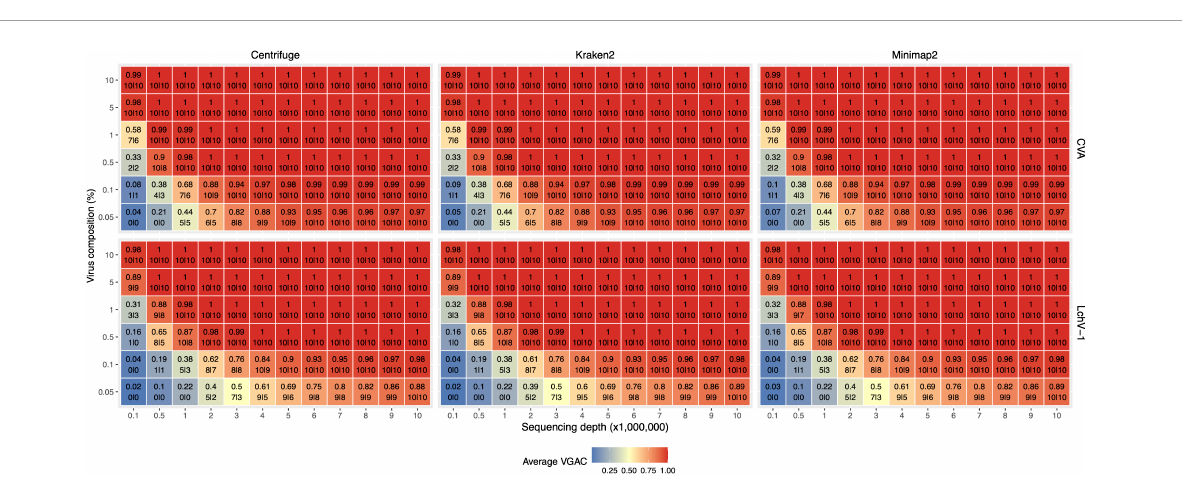
FIGURE5 VGAC dependence on viral abundance, depth of sequencing and identification of replicases. In order to analyze the relationship of VGAC (viral genome assembly coverage) on viral abundance, depth of sequencing and the presence of replicases, synthetic HTS data were generated with different abundance of viral reads. The viruses with the shortest and the longest genome length of the Pavium panel-I were assayed only [CVA (cherry virus A) and LChV-1 (little cherry virus 1) respectively]. The heatmap represents the VGAC obtained (indicated in each cell in the upper value) at both the respective sequencing depth and the abundance (%) of the viral reads (represented in the vertical axis as% viral composition of the corresponding 3% of viral reads of the sequencing depth); bottom numbers inside a cell indicates the number of replicases found in the respective assembly of the 10 subsampled sets at 80% alignment length/80% similarity, and 90% alignment length/90% similarity (both numbers separated by a pipe symbol).